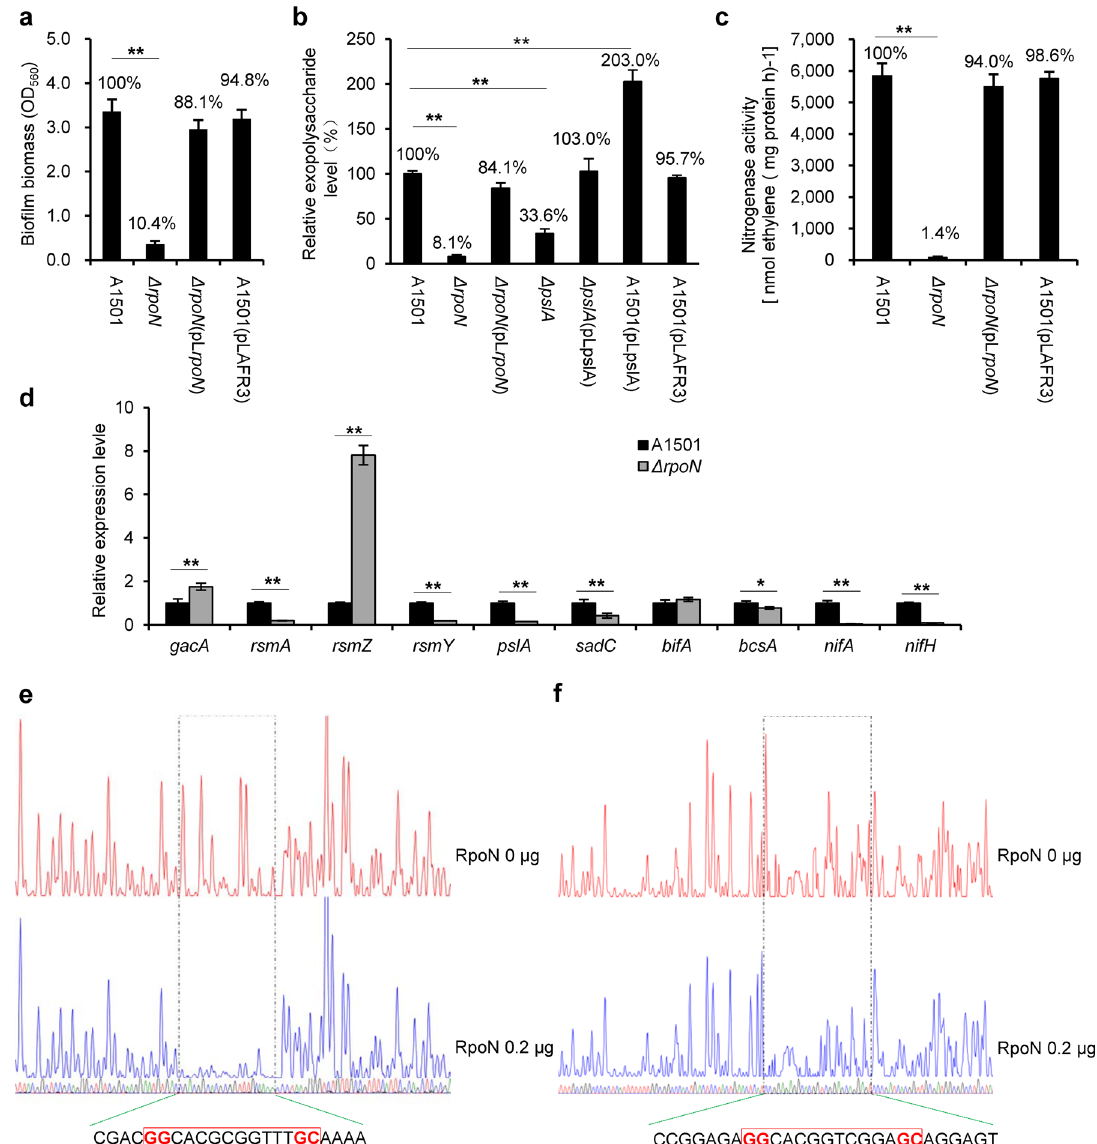
Fig. 3 Regulation of nitrogen- fi xing bio fi lm formation by rpoN . a Effect of rpoN on bio fi lm formation 48 h after inoculation, comparison of bio fi lm biomass obtained with the WT (containing or not the plasmid vector), the rpoN mutant and the complemented strains. b Relative exopolysaccharide levels in the WT (containing or not the plasmid vector), rpoN and pslA single mutant, complemented, and overexpression strains determined by HPLC analysis. c Effect of rpoN mutation on nitrogenase activity. d Relative expression levels of nif genes and bio fi lm- related genes in the nitrogen- fi xing bio fi lm cells of the WT A1501 versus that of the rpoN mutant. Each error bar represents the standard deviation of three independent experiments. Asterisks indicate statistical signi fi cance when compared to the wild-type control by one-way ANOVA with LSD multiple-comparison test: * p < 0.05; ** p < 0.01. e , f DNase I footprinting analysis of the nifA ( e ) and pslA ( f ) promot e r probes (300 ng) using puri fi ed RpoN protein added at 0 (upper panel) and 0.2 μ g (lower panel). The RpoN-protected region is indicated by a dotted box, with the nucleotide sequence shown at the bottom. The RpoN-binding site is marked by a red